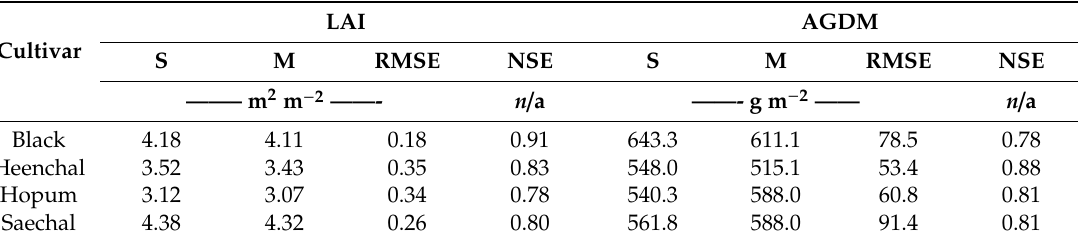
Table 2. Error statistics of root mean square (RMSE) and Nash–Sutcli ff e e ffi ciency (NSE) between the simulated (S) and measured (M) values of leaf area index (LAI), and above-ground dry mass (AGDM) of four barley cultivars at Chonnam National University (CNU), Gwangju, South Korea in 2018 for model calibration.